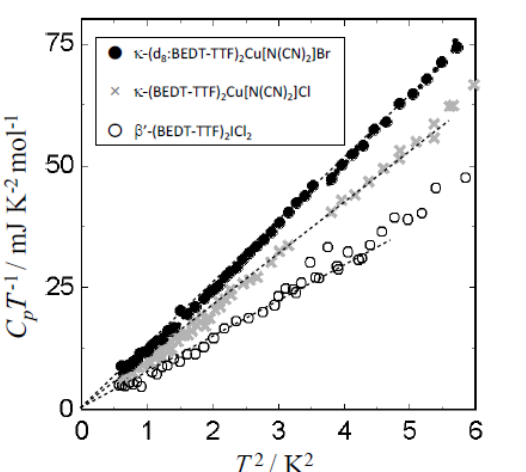
Cu[N(CN) ]Cl and deuterated κ -(BEDT-TTF) 2